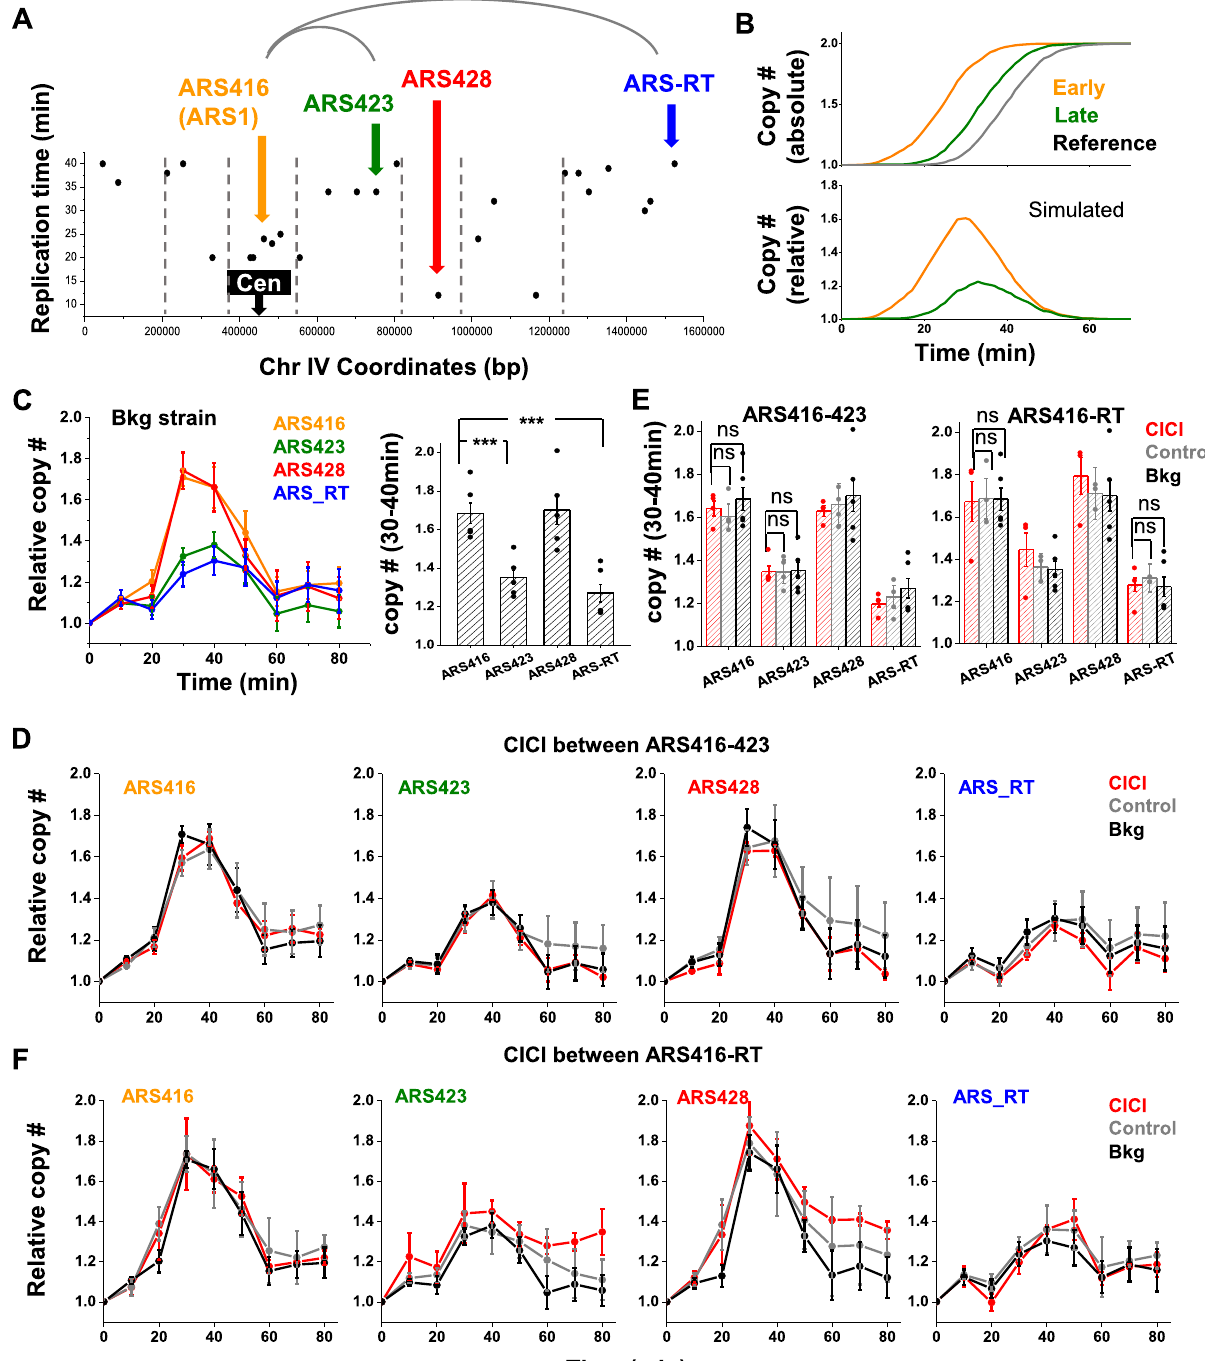
Fig. 6 CICI has no effect on replication timing. A The replication timing of different ARS sequences (data from Raghuraman et al. 37 ). The vertical lines represent TAD boundaries 48 . We choose four ARSs in four different TADs, ARS416, ARS423, ARS428, and ARS-RT for further testing. B Expected copy number as a function of time for different ARS sequences, as well as the relative copy number normalized by a control region with late replication. C The relative copy number as a function of time of the ARS sequences highlighted in A . Five biological repeats were included. The bar diagram on the right shows the average copy number of each ARS between 30 and 40 min after G1 release. Error bars represent standard error (same for panels below). The differences between ARS416 and ARS423/ARS-RT are statistically signi fi cant (one-sided Student ’ s t -test, P values < 0.001). D Consequence of CICI between ARS416 and ARS423 on replication timing (four biological repeats for each of CICI and control). The four panels show the relative copy number of the four ARSs in the CICI strain (LacO and TetO inserted near ARS416 and ARS423), control strain (same LacO and TetO arrays, but LacI and TetR are not conjugated to FKBP12 and FRB), and background strain (no CICI components). All the measurements were carried out in the presence of rapamycin. E Average ARS copy number between 30 and 40 min derived from data in D and F . No signi fi cant difference in replication timing was detected in CICI condition (two-sided Student ’ s t -test). F Same as in D except the CICI is between ARS416 and ARS-RT (TetO inserted near ARS-RT in the CICI and control strains, three biological repeats for each of CICI and control). Source data for B – F are provided as a Source Data fi le. NATURE COMMUNICATIONS| (2022) 13:757 |https://doi.org/10.1038/s41467-022-28416-3|www.nature.com/naturecommunications